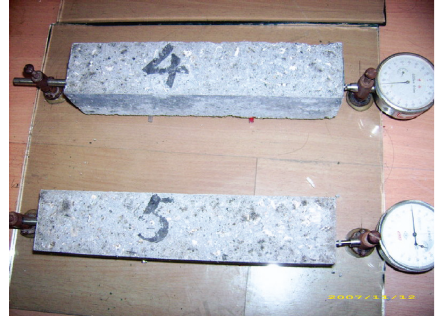
Figure 14: Setup of dry shrinkage test.